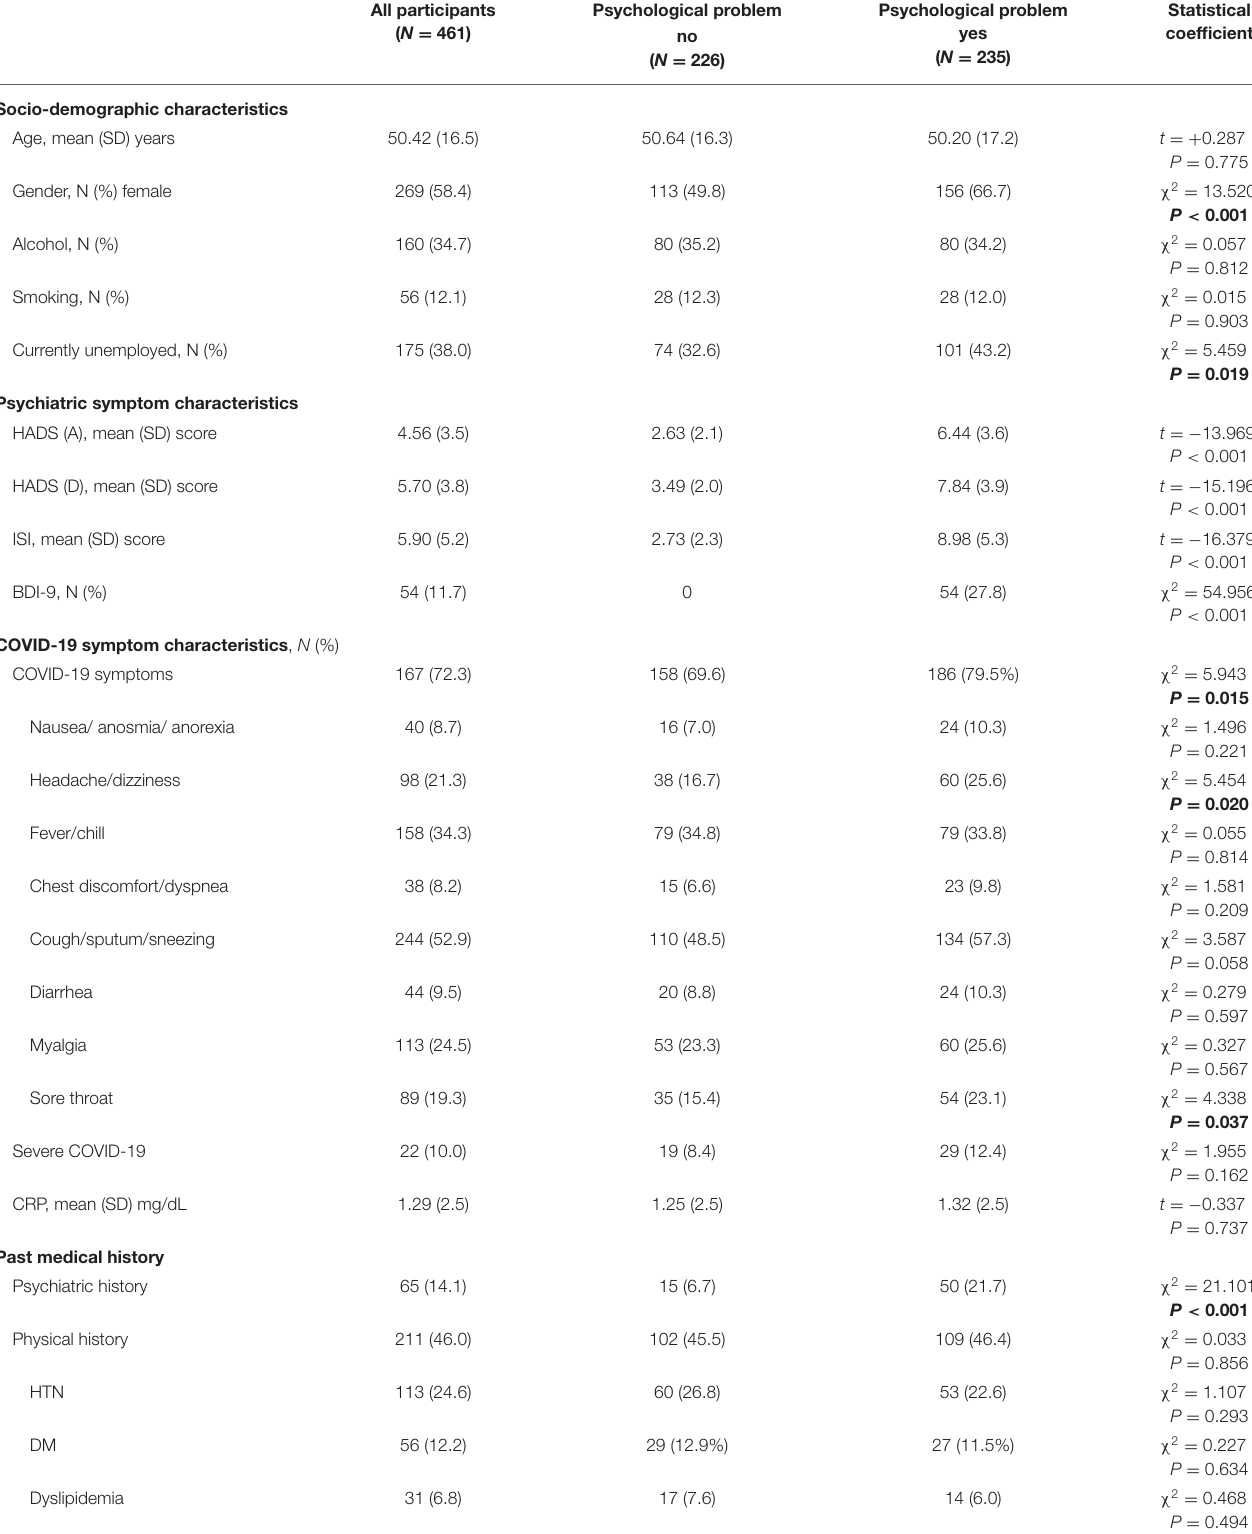
TABLE 1 | Baseline characteristics by common mental health problem as assessed using the HADS, BDI-9, and ISI at admission after COVID-19. All participants ( N =